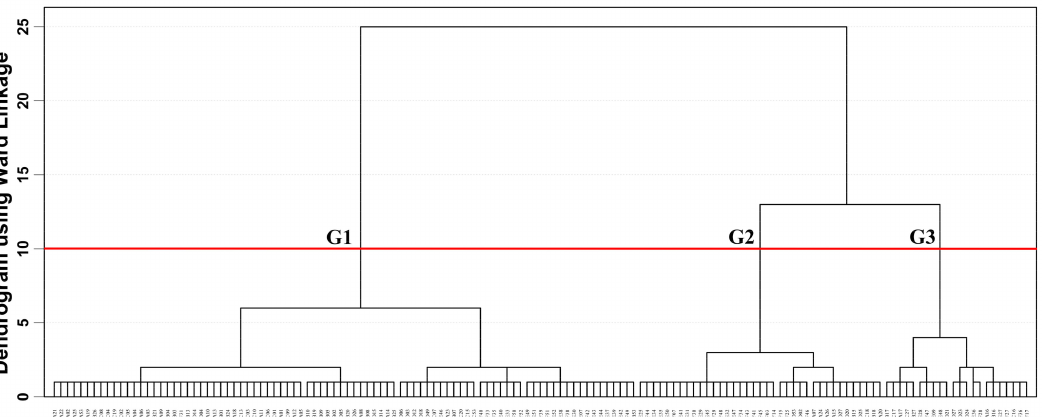
Figure 4. Dendrogram of the Q-mode hierarchical cluster analysis. ((A–F) represent groundwater sampling points in 1996, 2001, 2003, 2013, 2016, and 2022, respectively).